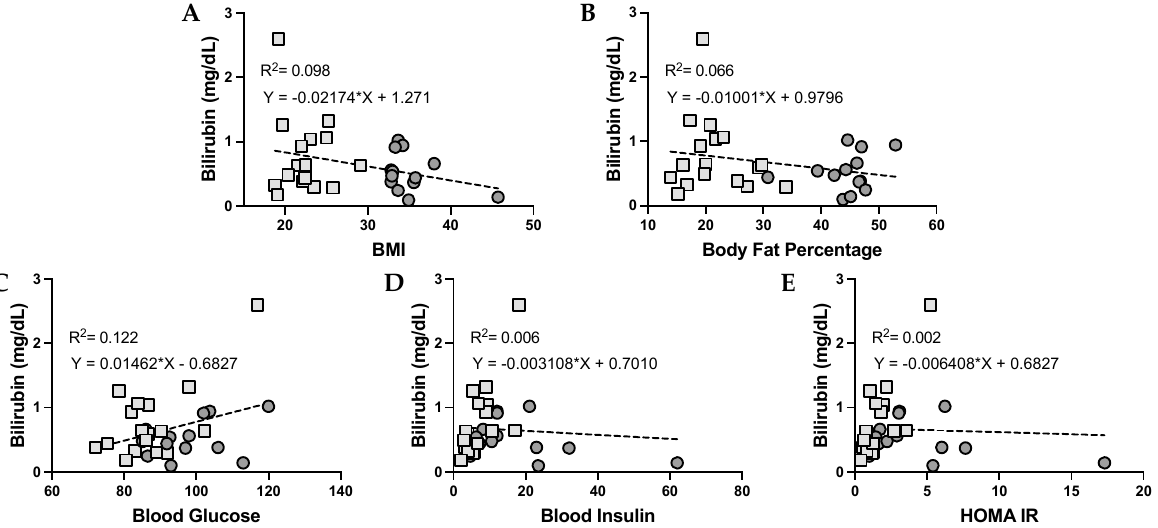
Figure 5. Bilirubin levels and correlations with metabolic phenotypes in women and men . Com- parisons of metabolic phenotypes in women and men with plasma bilirubin levels for ( A ) BMI, ( B ) body fat percentage, ( C ) blood glucose, ( D ) blood insulin, and ( E ) HOMA IR. The data were